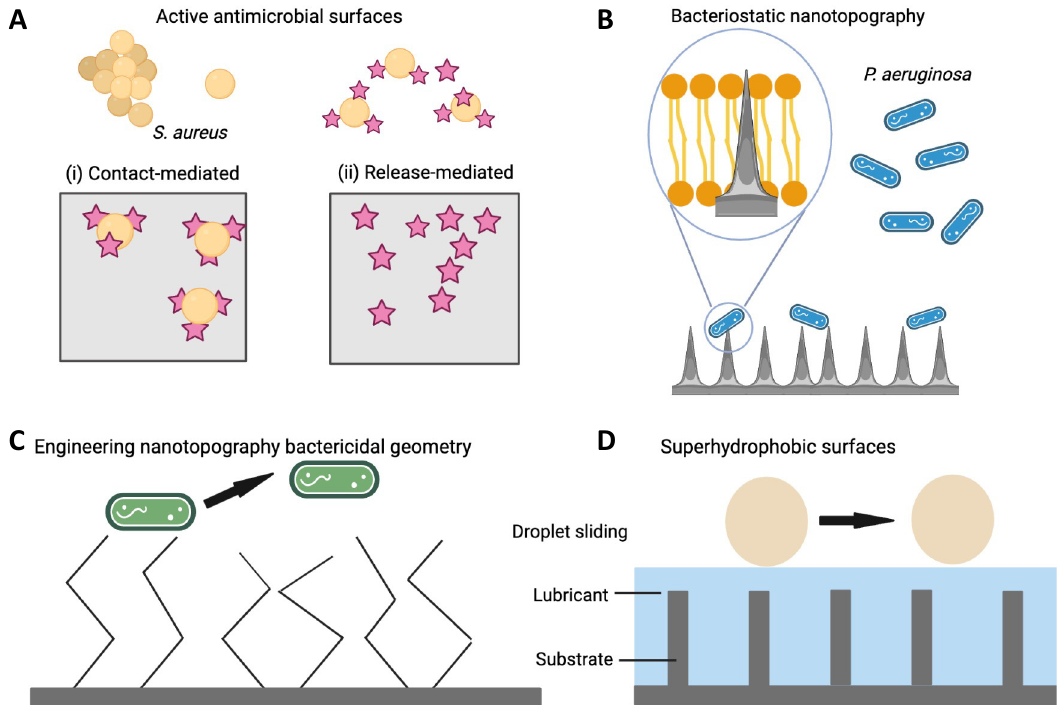
Figure 2. Schematic illustration of various antimicrobial and drug-free strategies currently under investigation to combat device-related infection. ( A ) Active antimicrobial surfaces utilise antimicrobial agents that have been coated on the surface or encapsulated within coatings to kill or impede bacteria growth. They exert their effect when (i) bacteria contact the antimicrobial surface or (ii) when released. Drug-free strategies include engineering ( B ) bactericidal nanotopographies and ( C ) device surfaces to minimise bacterial adhesion including polymeric brushes that impede microbial attachment owing to steric hindrance, or ( D ) the use of superhydrophobic surfaces to repel microbes, such as SLIPS (slippery liquid-infused porous surfaces). Created with BioRender.com.